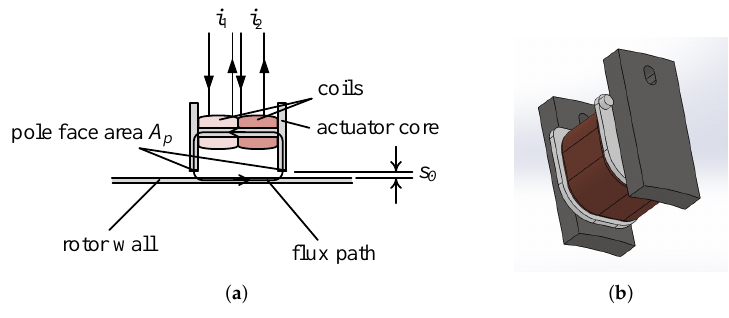
Figure 6. Multi-coil actuator for thin-walled rotors ( a ) schematic ( b ) solid model. Table 2. Physical properties of thin-walled steel